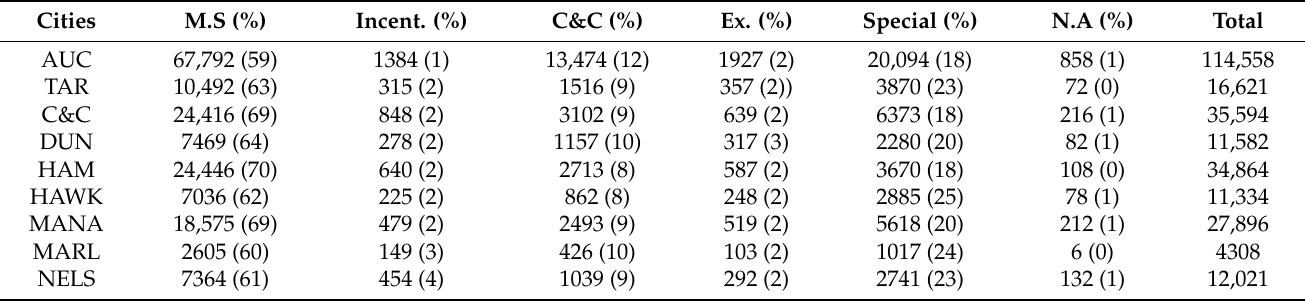
Table A1. Total volume by event type dimension for eight years